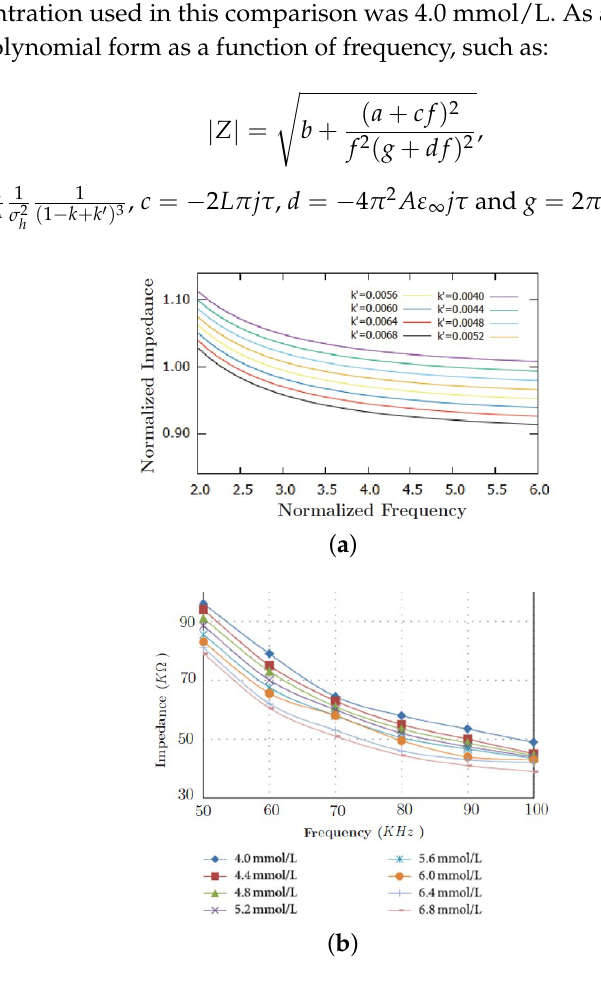
Figure 2. Normalized impedance spectra calculated by the proposed mathematical model ( a ) and the experimental data ( b ) presented by [8] (License CC BY 3.0 at https://creativecommons.org/licenses/